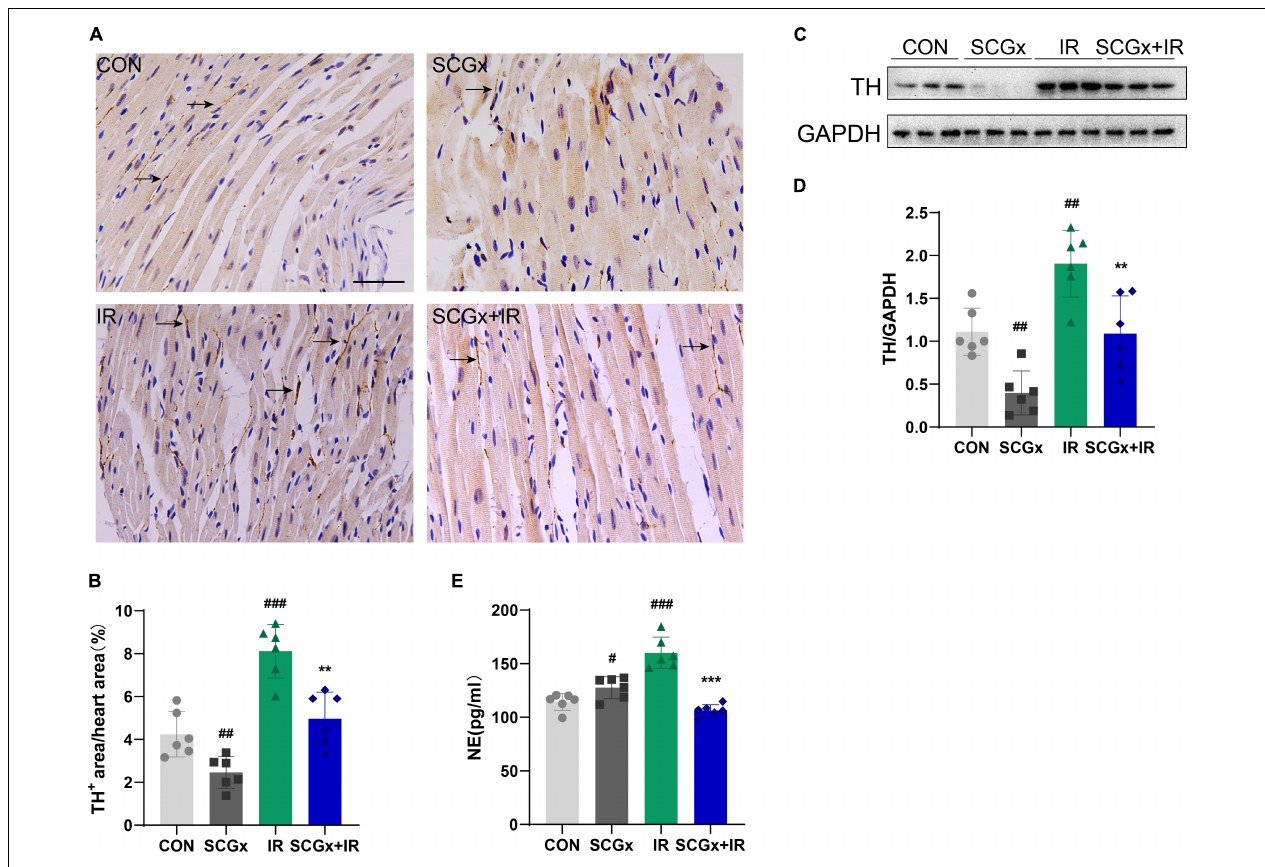
FIGURE 2 | Sympathetic denervation reduces the sympathetic excitability of myocardium. (A,B) Quantification of intramyocardial sympathetic nerve by immunohistochemistry staining with an antibody directed against TH. Arrows indicate the immunostaining neurons. scale bar: 100 µ m. ( n = 6) (C,D) The expression of TH protein in heart tissue was examined using western blotting analyses. ( n = 6) (E) Detection of Norepinephrine (NE) in mice serum. n = 6, 0.001 < ** P < 0.01, and ***P < 0.001 compared with the I/R group. # P < 0.05, 0.001, ## P < 0.01, and ### P < 0.001 compared with the CON